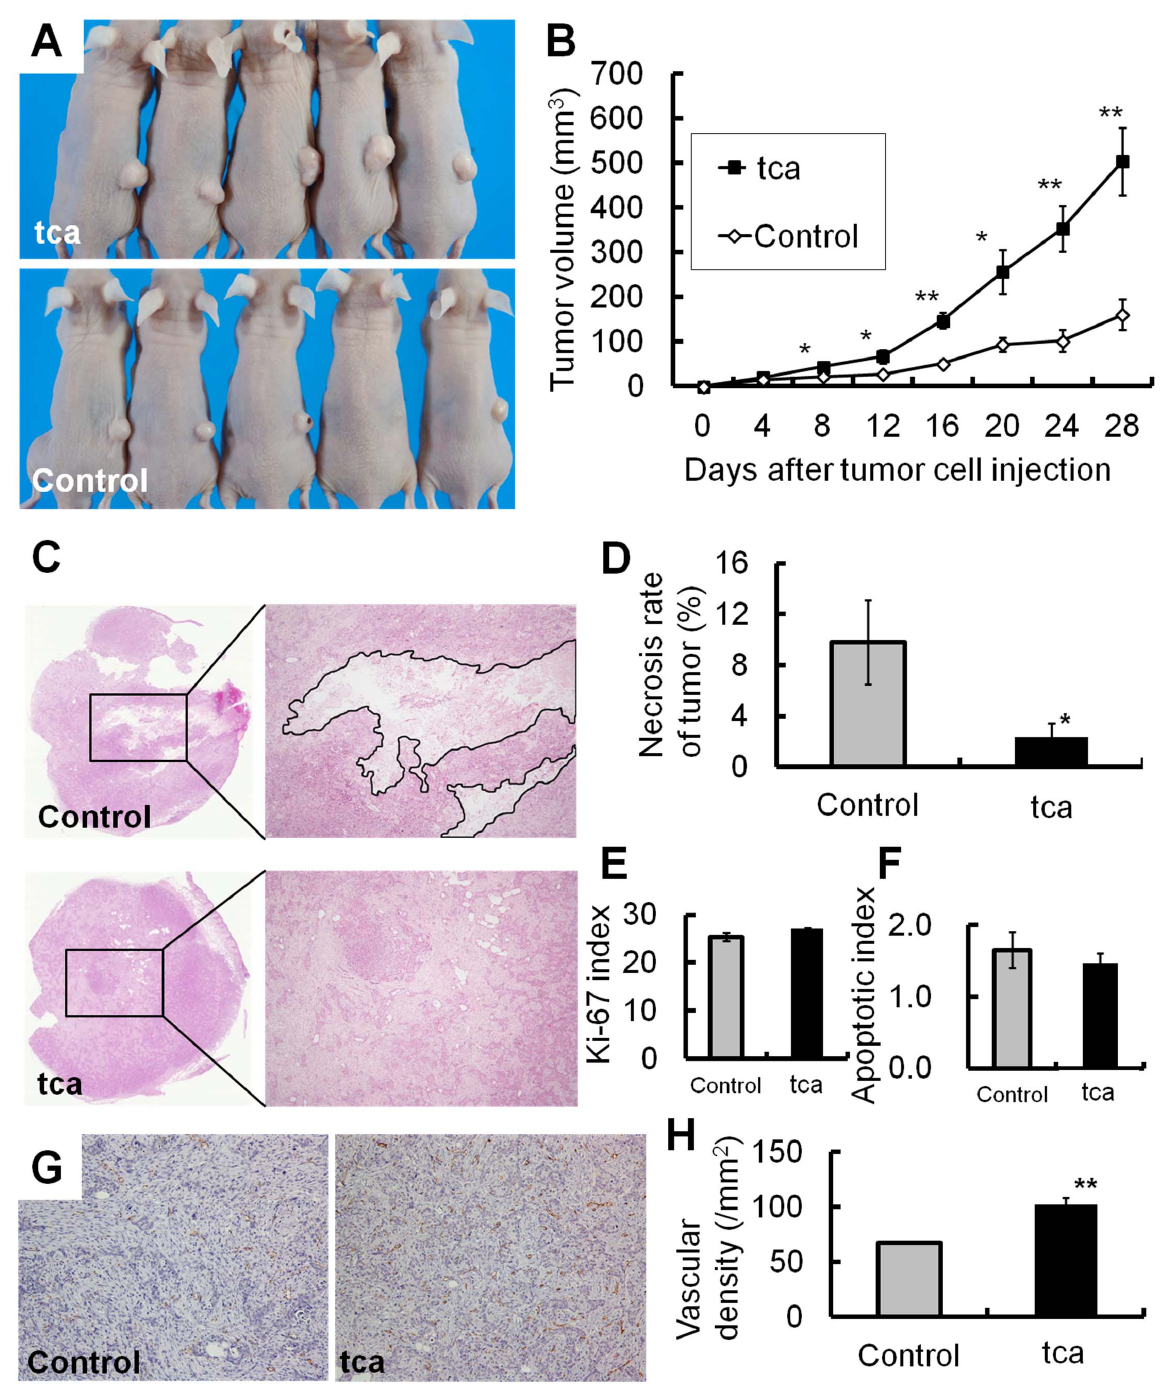
Figure 5. Effects of TCA exposure on tumor xenografts. (A) Tumor xenografts derived from tca and control cells after 28 days. (B) Growth curves of tumor xenografts from tca and control cells. TCA pretreatment significantly enhanced in vivo growth at day 28 after tumor cell injection (* P , 0.05, ** P , 0.01). (C) Necrosis (marked with black rim) in tumor xenografts from tca and control cells (magnification 6 40). (D) Necrosis was significantly reduced in tca cells compared with control cells (* P , 0.05). (E, F) There was no significant difference in the mean Ki-67 index (E: P= 0.0746) or mean apoptosis index (F: P= 0.5151) between tca and control cells. (G) Immunohistochemical detection of CD31-positive vascular endothelial cells (magnification 6 200). (H) Vascular density was significantly higher in tca cells than in control cells (** P ,